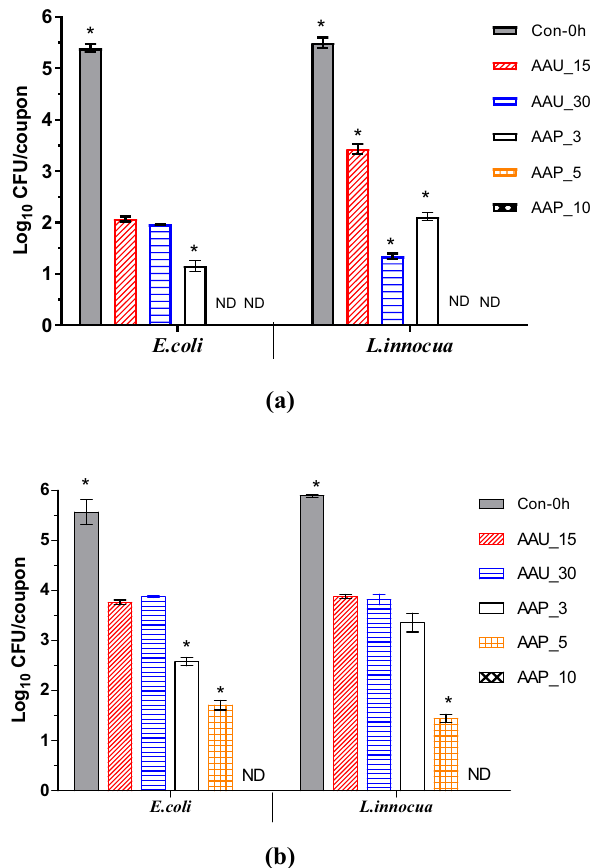
Figure 3. Inactivation efficacy of airborne acoustic ultrasound and atmospheric air plasma technology against ( a ) 48 h and ( b ) 96 h E. coli and L. innocua biofilms. ND: not detected, below detection limit. Vertical error bars indicate standard deviation (n = 4). Asterisk indicates significant differences (p ≤ 0.05) between different treatments for each bacterial strain, analysed by one-way ANOVA and Tukey multiple comparison post